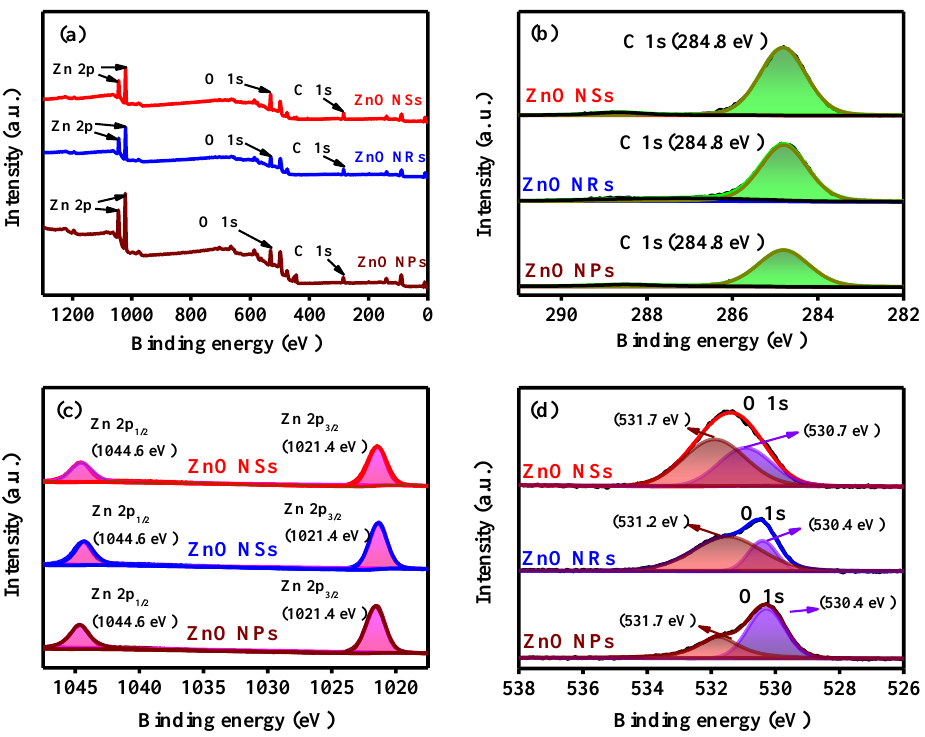
Figure 5. XPS survey scan spectrum for ( a ) all elements, ( b ) C 1s, ( c ) Zn 2p, and ( d ) O 1s of three ZnO